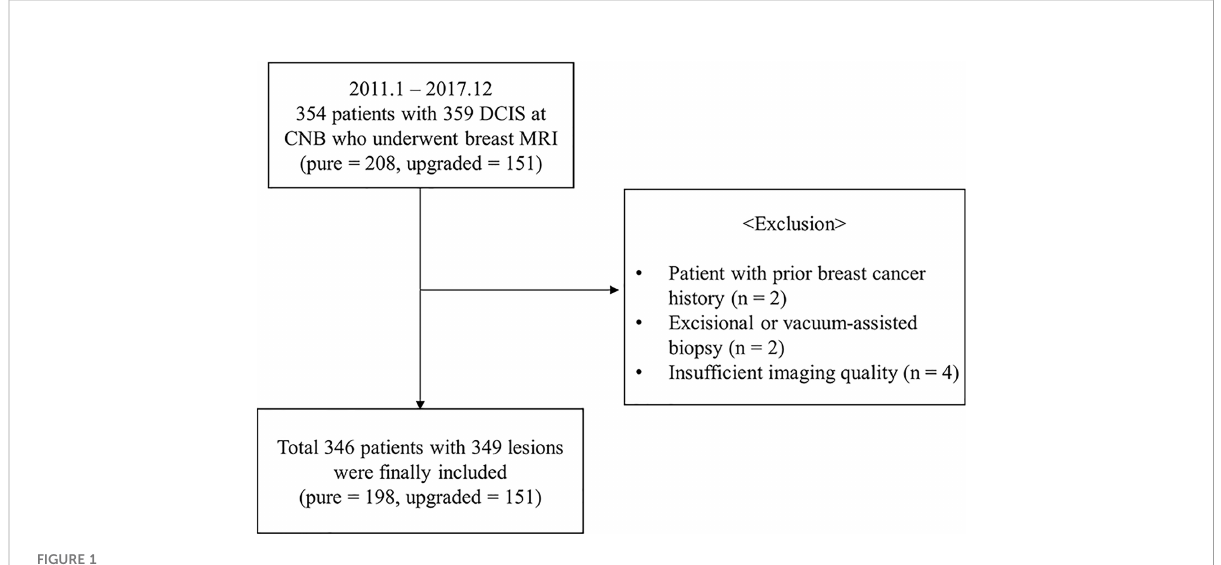
FIGURE 1 Flowchart of study population with exclusion